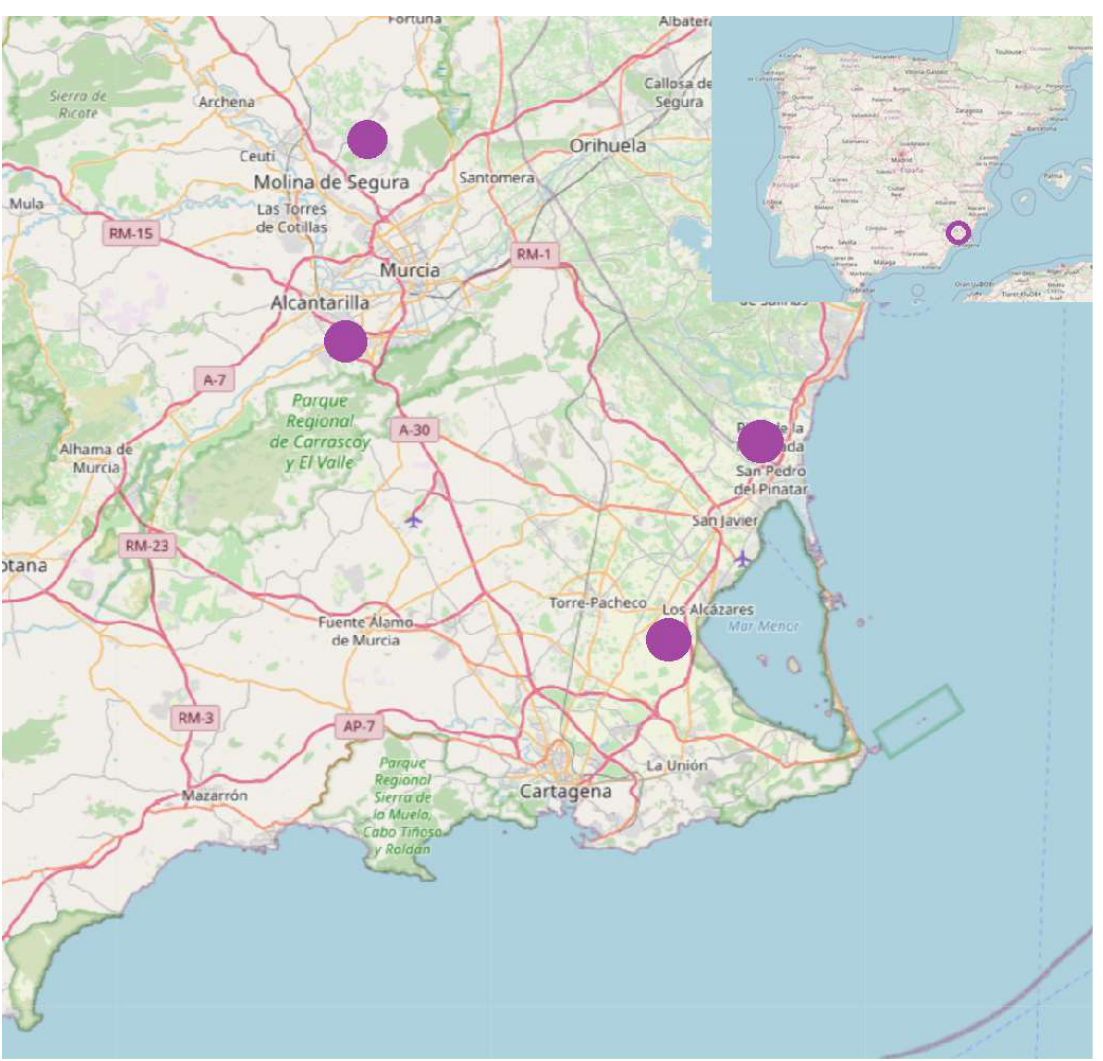
Figure 1. Location of four WWTPs in Murcia, SE Spain.